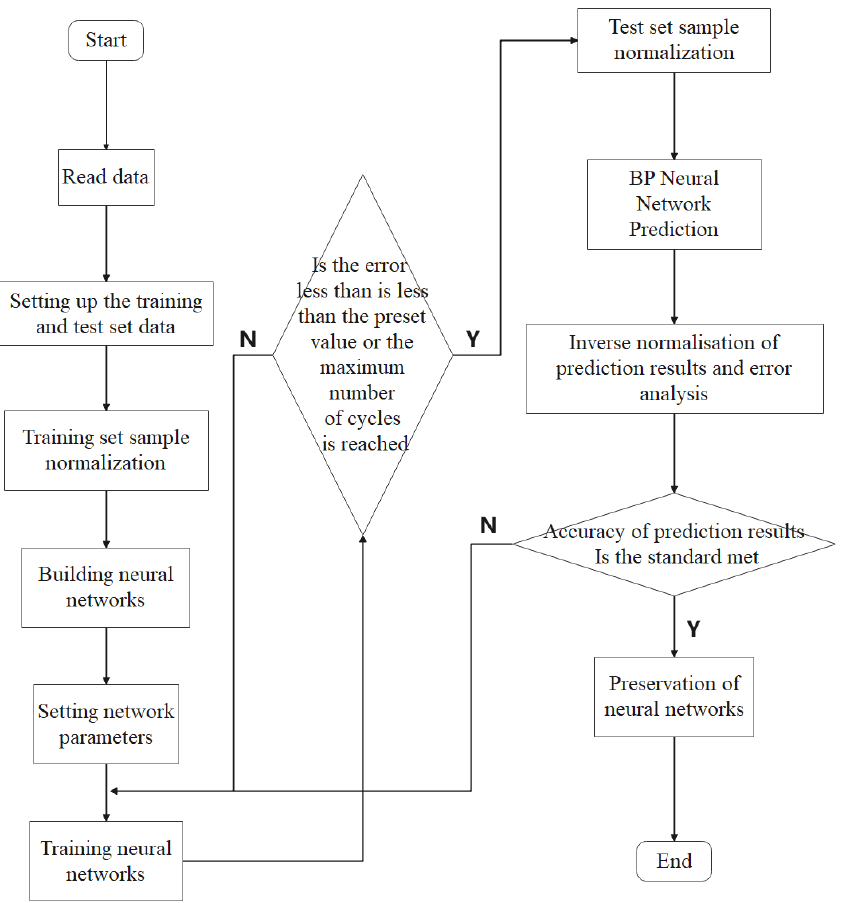
Figure 7. Flow chart of neural network training.